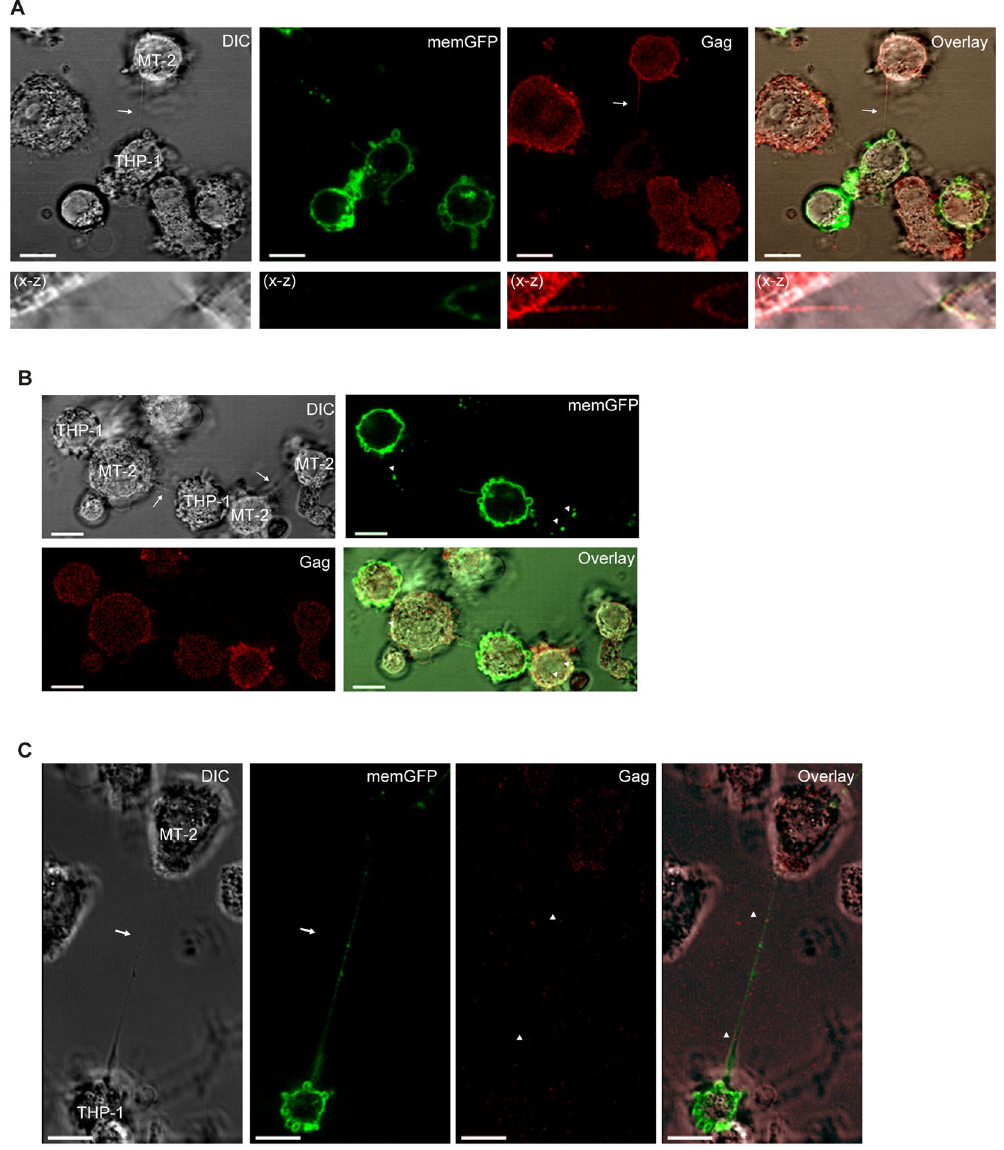
Figure 4. Gag present in TNT connecting HTLV-1 expressing cells and non-infected monocytes. ( A – C ) MT-2 cells and THP1 - memGFP (green) cells were co-cultured overnight, fixed and stained for p24Gag (red) before investigated for TNT connections by DIC and fluorescent confocal microscopy. Arrows indicate TNTs and arrowheads Gag. The X-Z plane is obtained from a Z-stack (total 23 slices of 1 µ m each). Images are representatives of three independent experiments performed in duplicates. Scale bar 10 µ